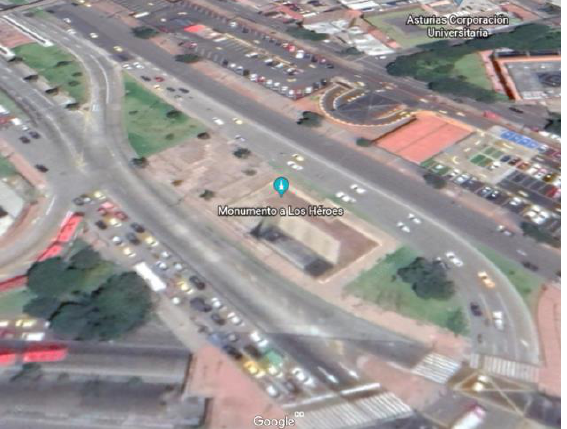
Figure 18: Overview of the Heroes Monument on Google Earth.